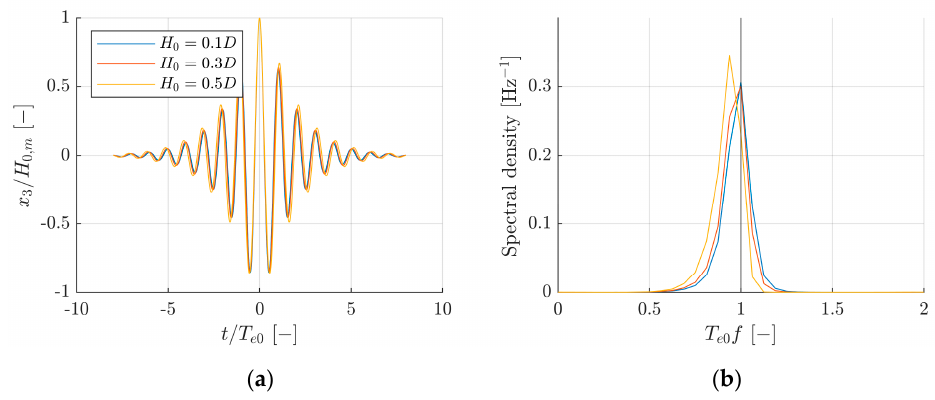
Figure 18. Conversion to periodic signal ( a ) and spectral density for all drop heights ( b ).